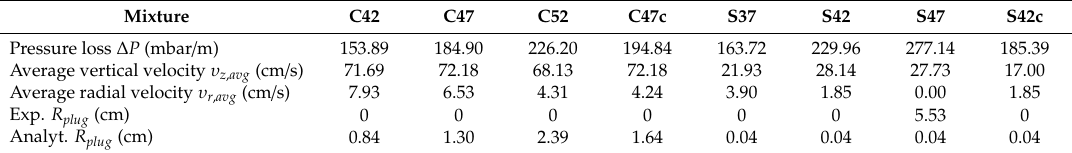
Table 6. Average radial and vertical velocity of surface, and the plug radii for specified pressure loss. Mixture C42 C47